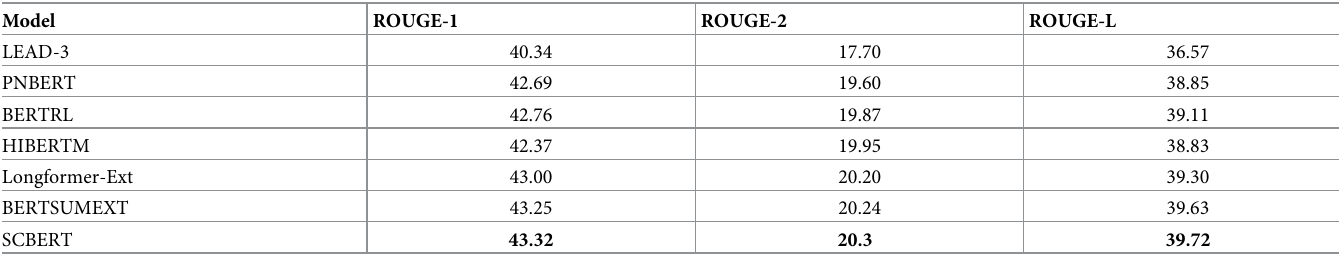
Table 1. The results of sentence centrality-enhanced EDS model based on BERT.